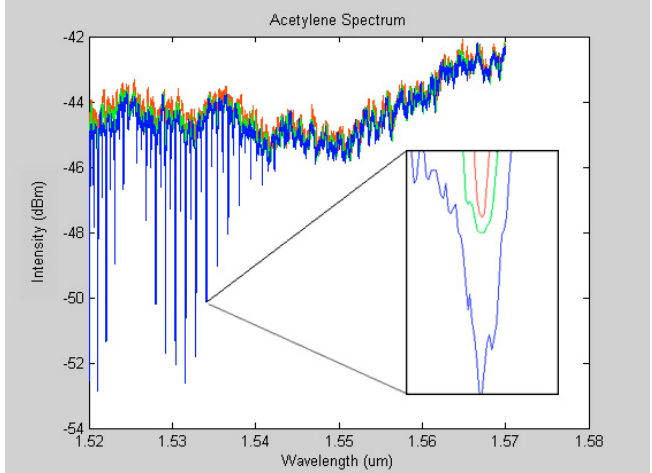
Figure 8. Pressure